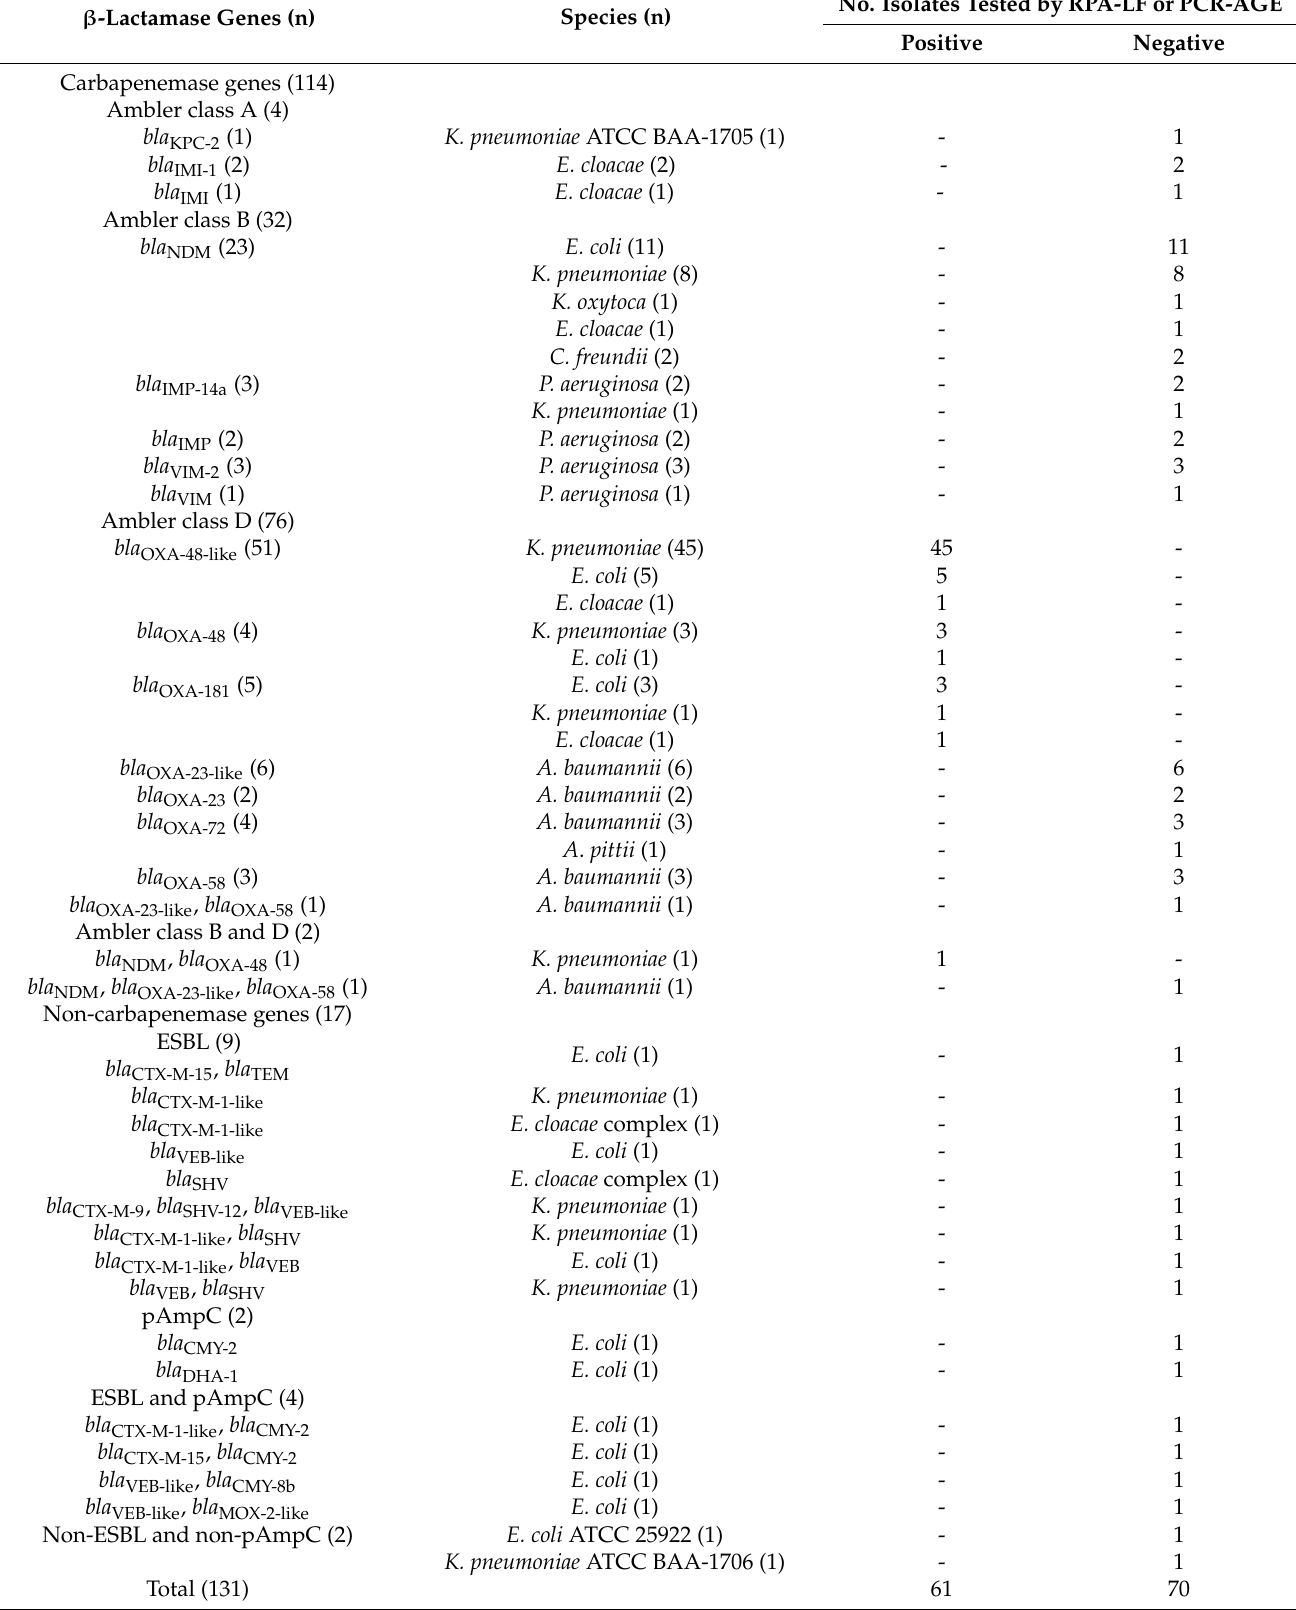
Table 1. Detection of the bla OXA-48-like genes in Gram-negative bacilli by the RPA-LF assay compared with the conventional PCR method as a gold